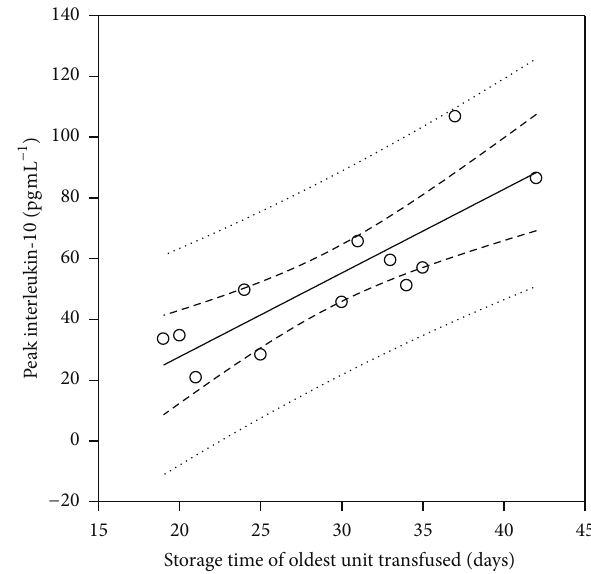
Figure 4: Scatter plot diagram of peak postoperative IL-10 values versus the duration of storage (in days) of the oldest unit of blood transfused. A strong correlation between the storage time of the oldest unit transfused and peak IL-10 values was demonstrated ( 𝑟 2 = 0.68 , 𝑃 < 0.001